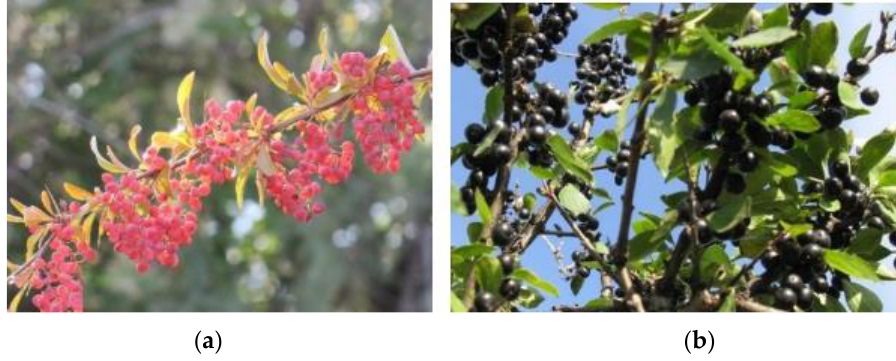
Figure 1. The fruits of B. nummularia and B. atrocarpa . ( a ) B. nummularia . ( b ) B. atrocarpa.